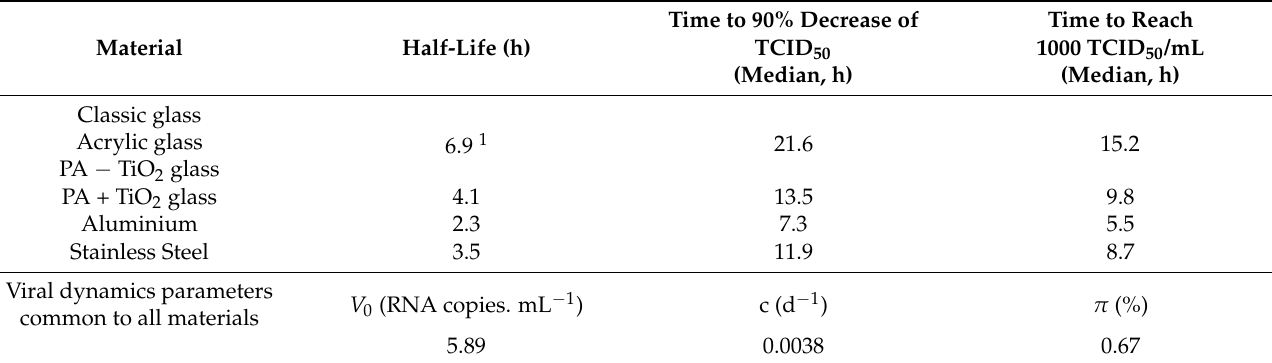
Table 1. Estimated parameters of the infective virus